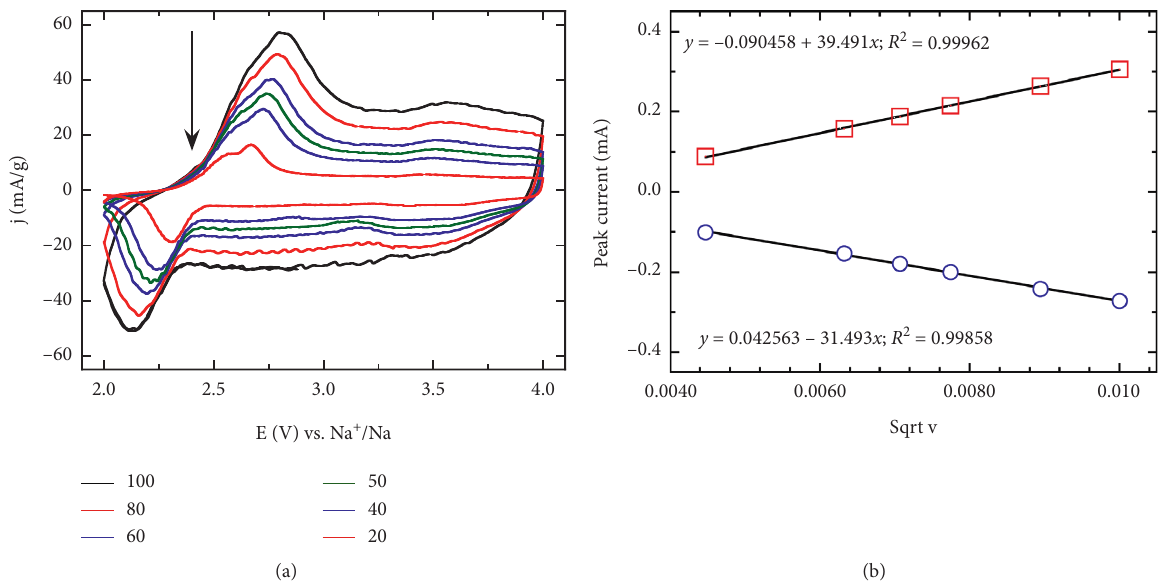
Figure 6: CV curve of sodium intercalation/deintercalation into Li the square root of the scan rate